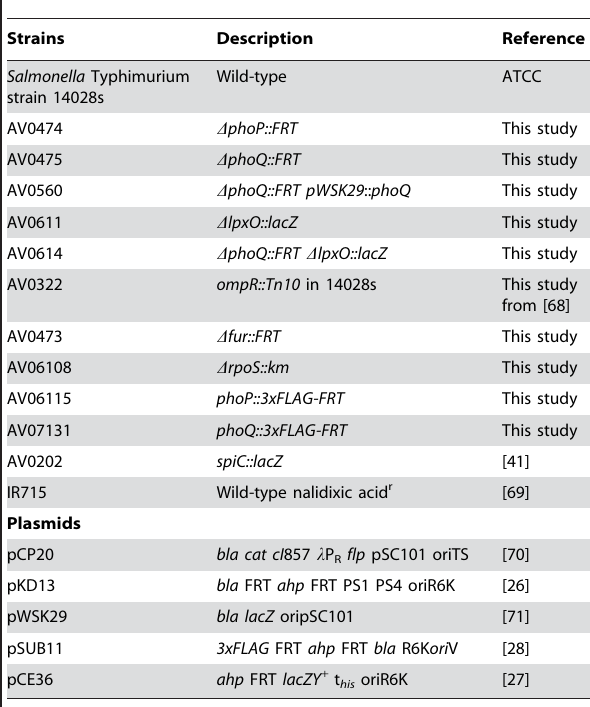
Table 1. Bacterial Strains and Plasmids